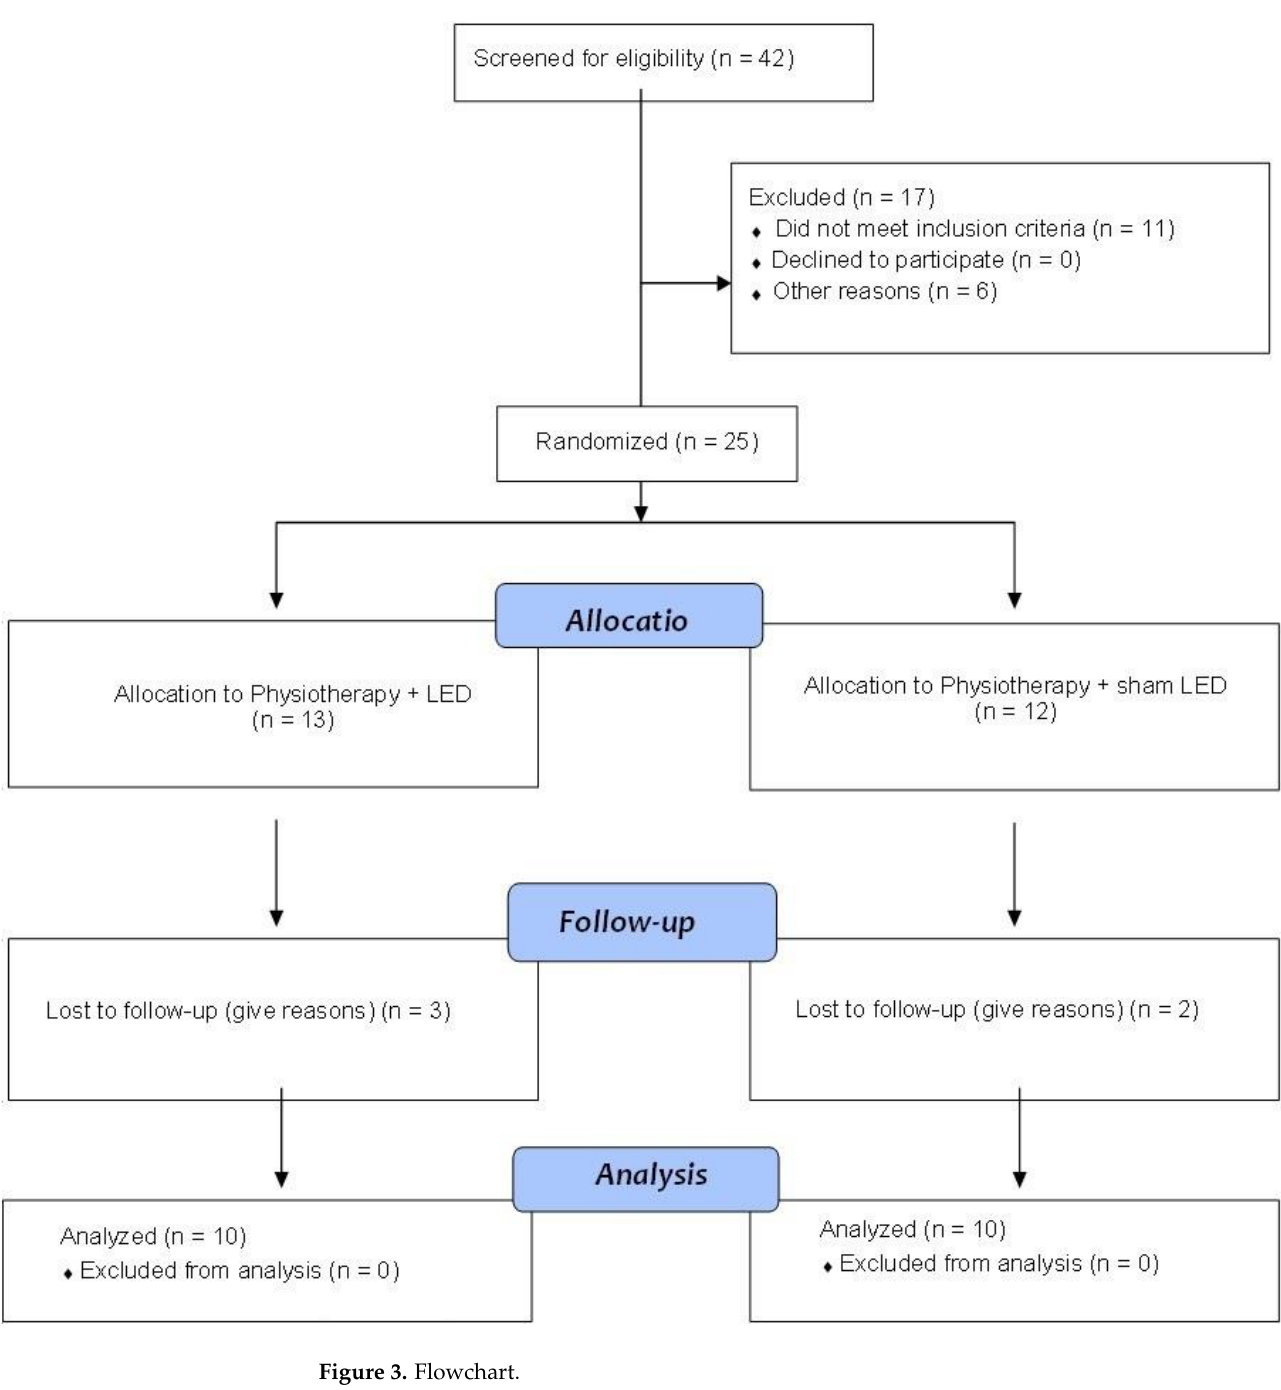
Figure 3. Flowchart. Figure 3.